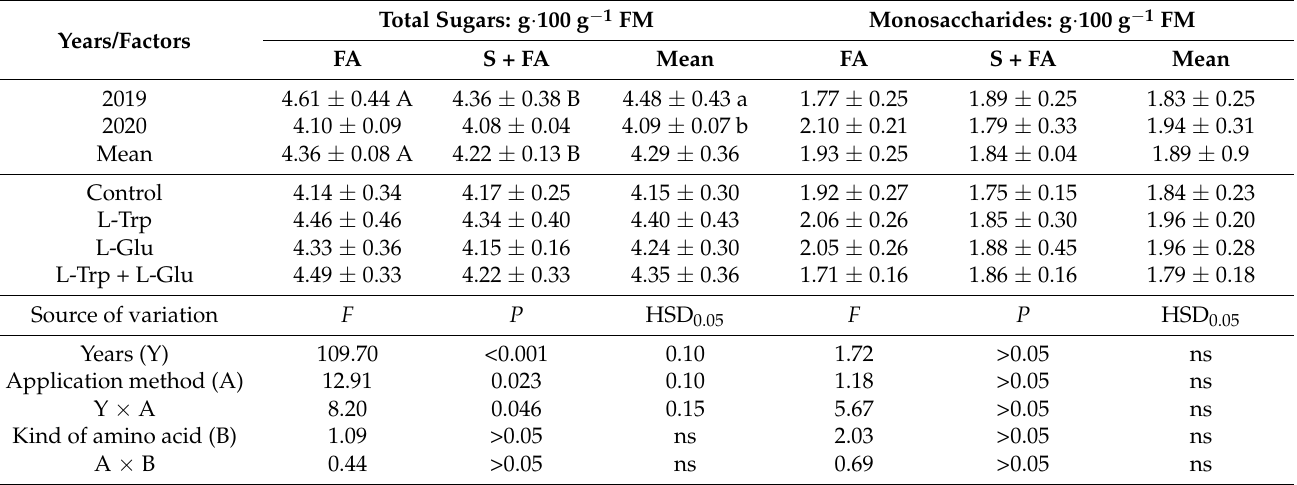
Table 7. The effect of L-tryptophan and L-glutamic acid, methods of their application, and years of sugar content in carrot storage